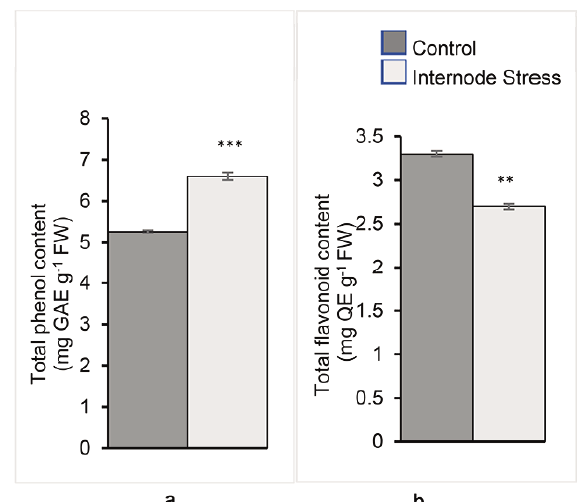
Fig. 3 ­ Total phenol content expressed as mg of gallic acid equi­ valent per gram of fresh weight (GAE g ­1 FW) after 48hrs of internode stress (a) and total flavonoid content expressed as mg of Quercetin Equivalent per gram of fresh weight (QE g ­1 FW) after 48hrs of internode stress (b). Standard error is indicated by vertical bars. The values correspond to the Mean ± SE , where n=3. Statistical analysis was performed by Student’s t test. Asterisks indicate Mean values significantly differ from control at P <0.05 (** indicate P = 0.0013 and *** indica­ te P = 0.0001).